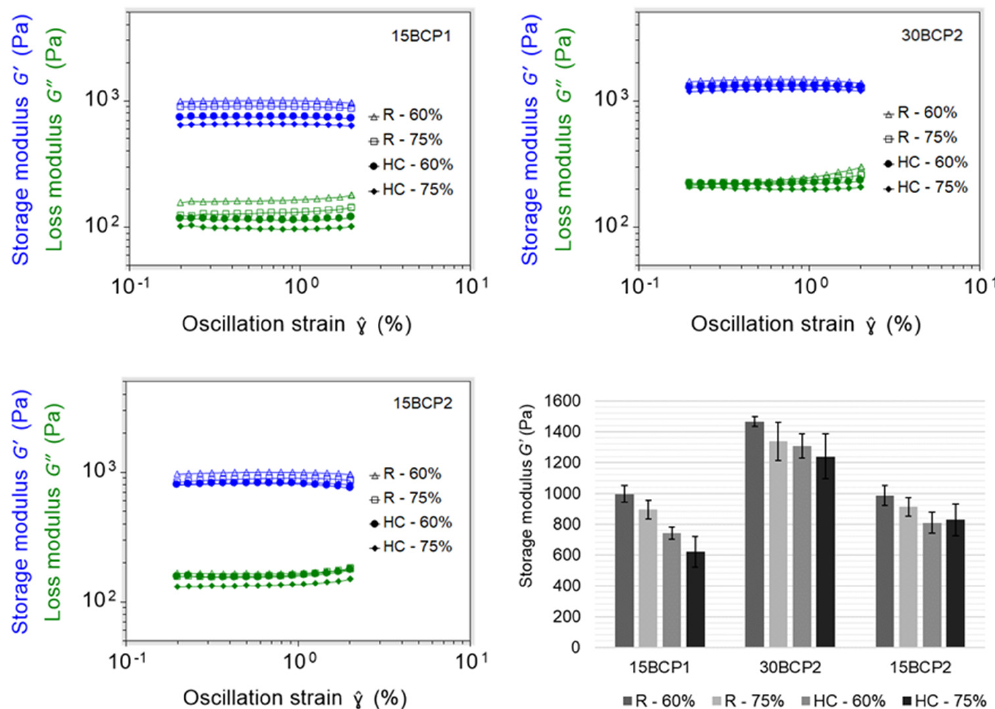
Figure 8. Amplitude sweep tests on 3D-printed figures and storage modulus detected at 1% strain for patterns rectilinear (R) and honeycomb (HC) at 60% or 75%